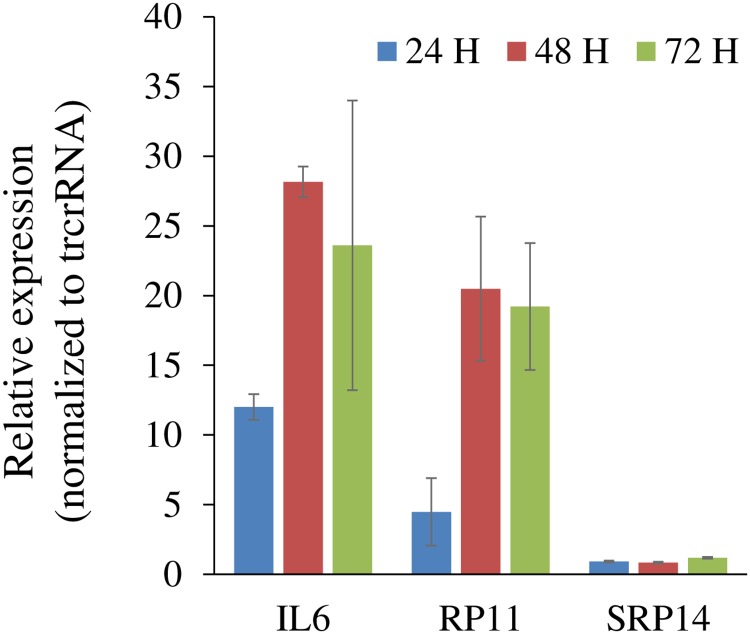
Upregulations of RP11 and IL6 occur in parallel.Time course of SG-286 activation in HEK293T. Cells were transfected with dCas9-VPR and SG-286 or trcrRNA for the indicated times. Indicated RNAs were quantified by qRT-, normalized to PPIA values and then divided by the trcrRNA/dCas9-VPR. Data represent the average of 3 experiments (± S.D.).